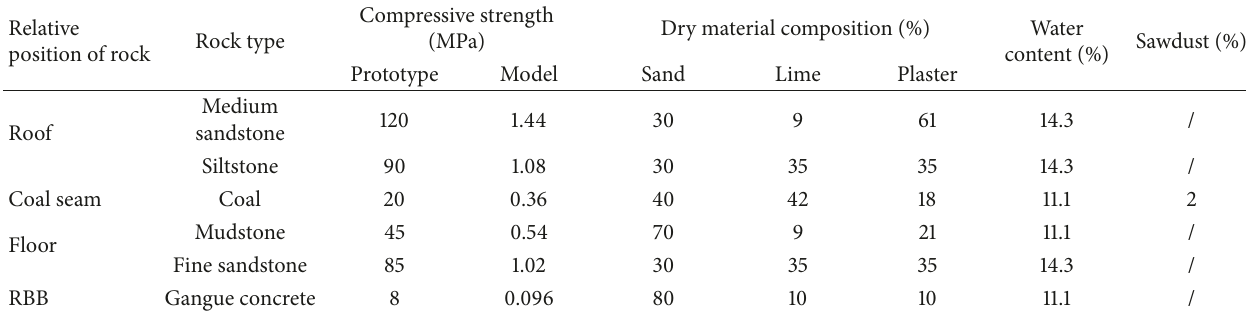
Table 2: Similar material